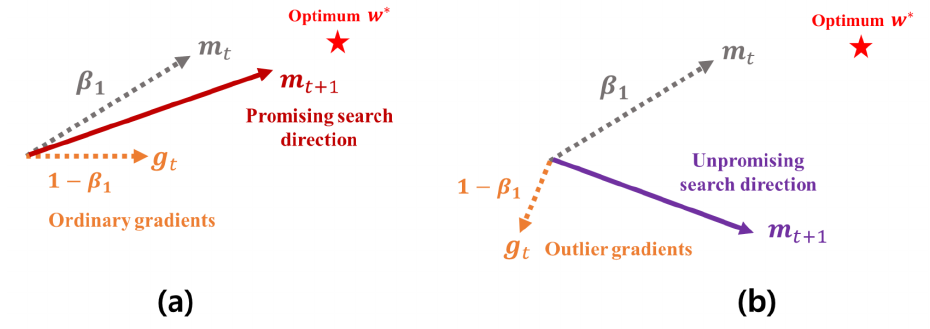
Figure 4. The example to explain how the outlier gradient negatively affects a direction the first momentum. ( a ) shows an ideal case that the first momentum is computed by the current momentum and the ordinary gradient. In this case, the first momentum becomes further close to the optimal weight. On the other hands, ( b ) shows a bad case that the first momentum is distorted by the unpromising (i.e., unexpected outlier) gradient. In this case, its next search direction moves away from the optimal weight by the unpromising